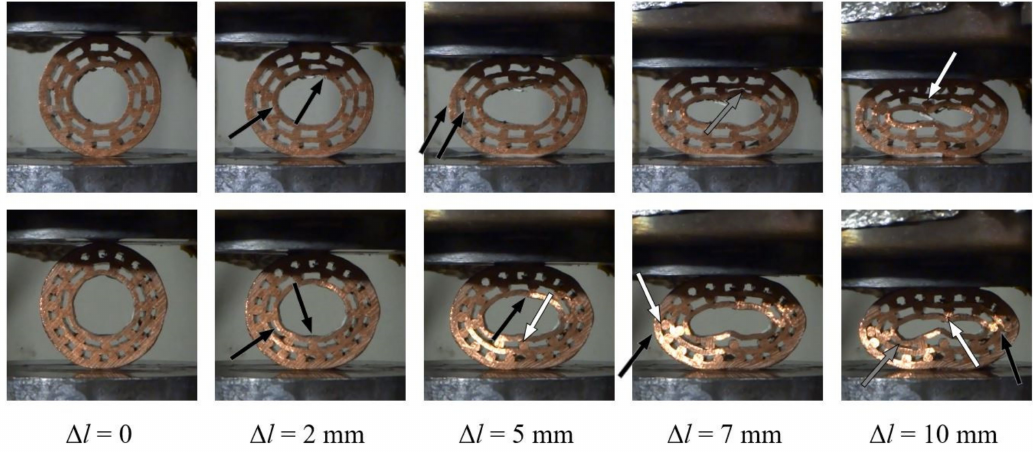
Figure 12. Deformation mechanism (white arrows denote debonding, black denote bending or buckling, and grey arrows denote contact) of the type 3 specimens (#3.1: upper row; #3.2: lower row).